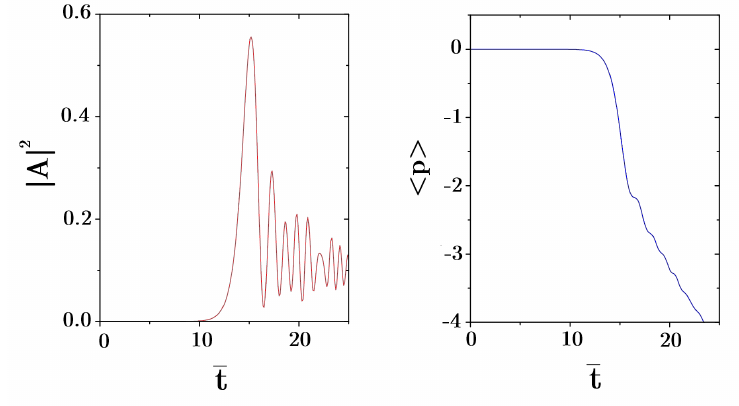
Figure 5. | A | 2 and (cid:104) ¯ p (cid:105) vs. ¯ t for ¯ δ = 0 and ¯ κ =